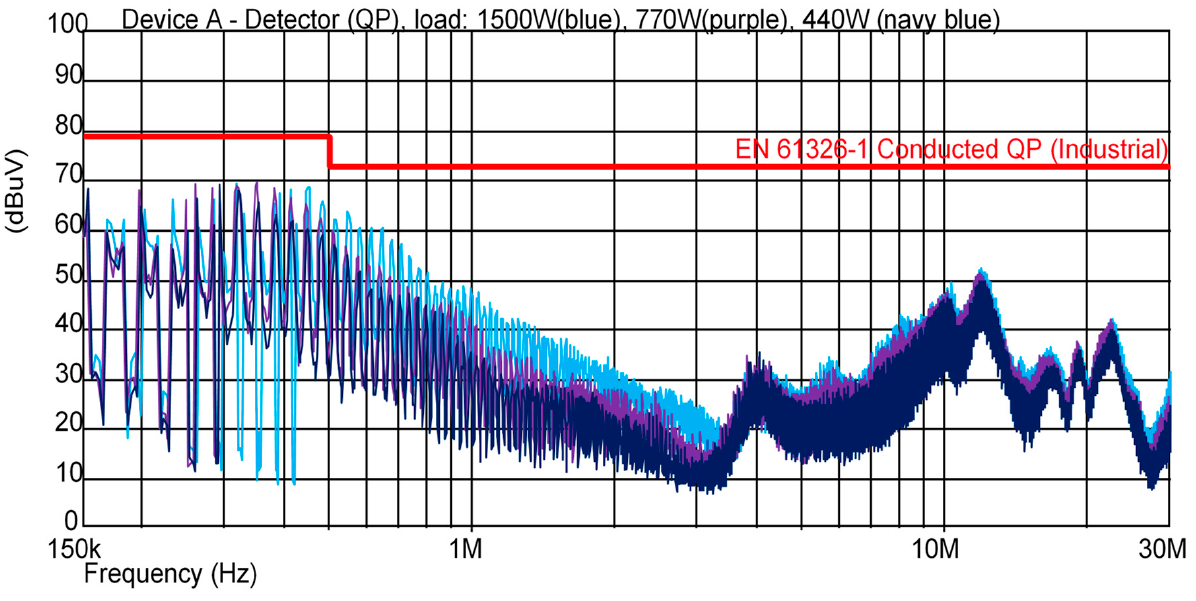
Figure 3. Frequency spectrum of conducted emission of the PWM-based power source (device A) for frequency of generated voltage by the device under test equal to 50 Hz and the values of the active load power equal to 1500, 770, and 440 W.